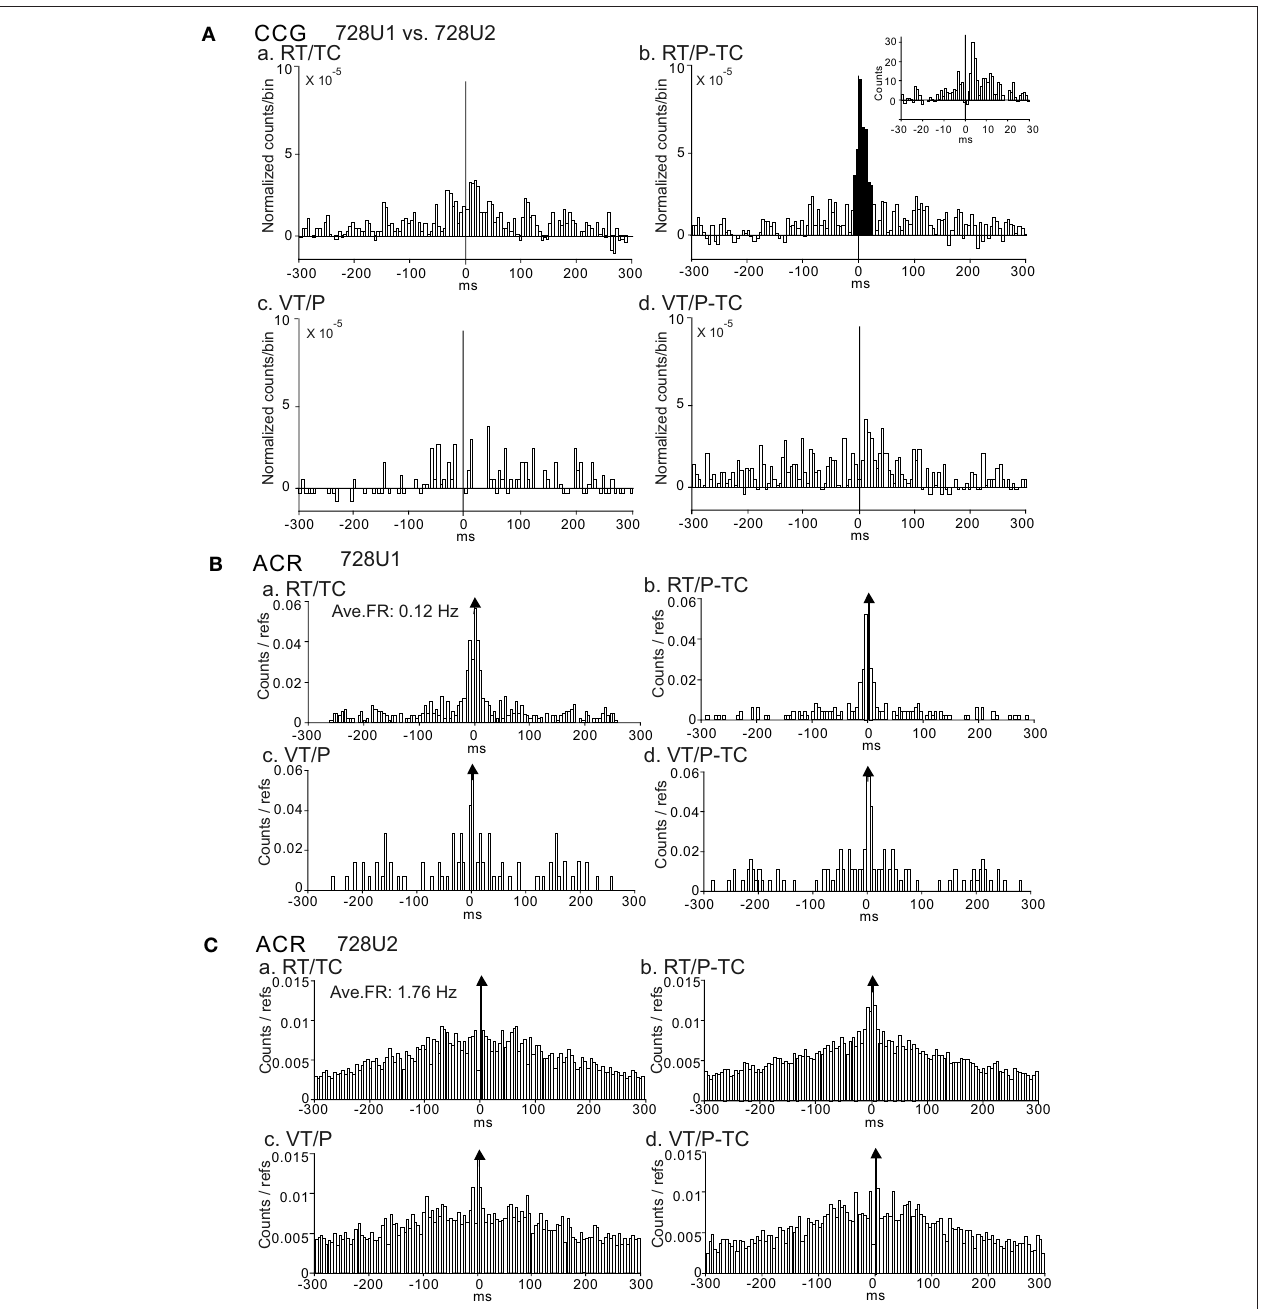
264 and 2006 spikes in the RT/TC, 340 and 3034 spikes in the RT/P-TC, 91 and 1966 spikes in the VT/P, and 163 and 1946 spikes in the VT/P-TC tasks, respectively. (B,C) ACRs of the same neurons in (A) [ (B) 728U1; (C) 728U2]. Note a sharp peak in 728U1, and a broad peak in 728U2. It is noted that 728U1 and 728U2 were not complex spike cells. Other descriptions as for Figure